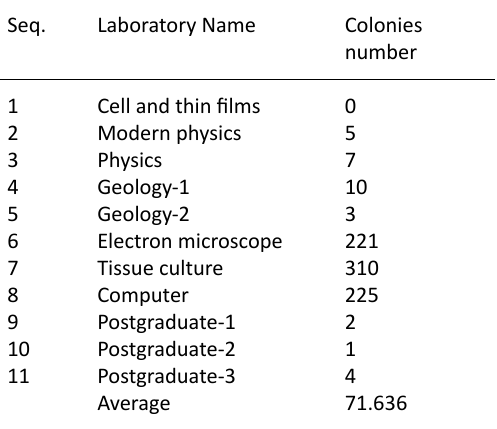
Table 2. Bacterial contamination of laboratories doors handles Seq.